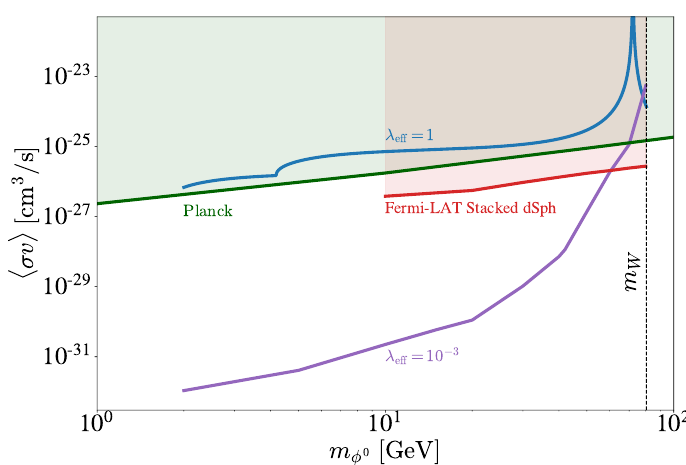
Figure 7: Annihilation cross sections for inclusive gamma ray and positron produc- tion when the φ 0 mass is below M and the corresponding limits on that quantity from Fermi-LAT observations of dwarf spheroidal galaxies (red), derived from the likelihood analysis of MadDM [ 29 ] , as well as the CMB limit (green) derived using the spectra of e + and e − generated by